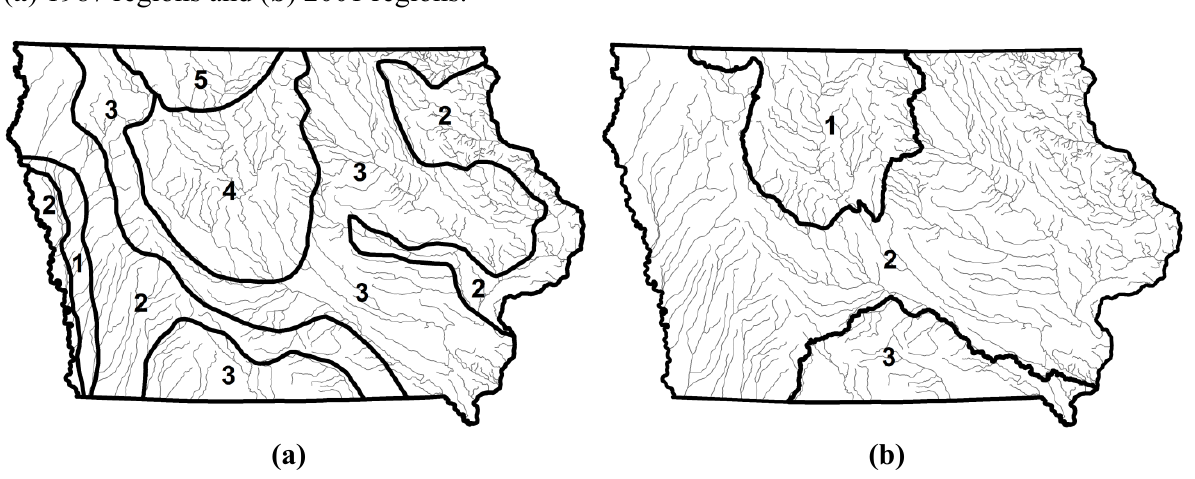
Figure 5. Hydrologic regions for utilizing annual exceedance regression equations ( a ) 1987 regions and ( b ) 2001 regions.